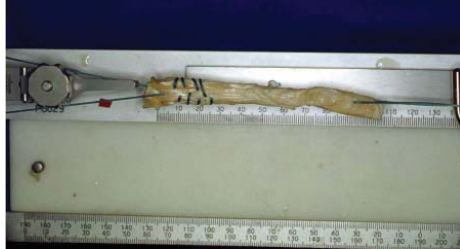
Figure 3 - Graft tensioned in preparation table